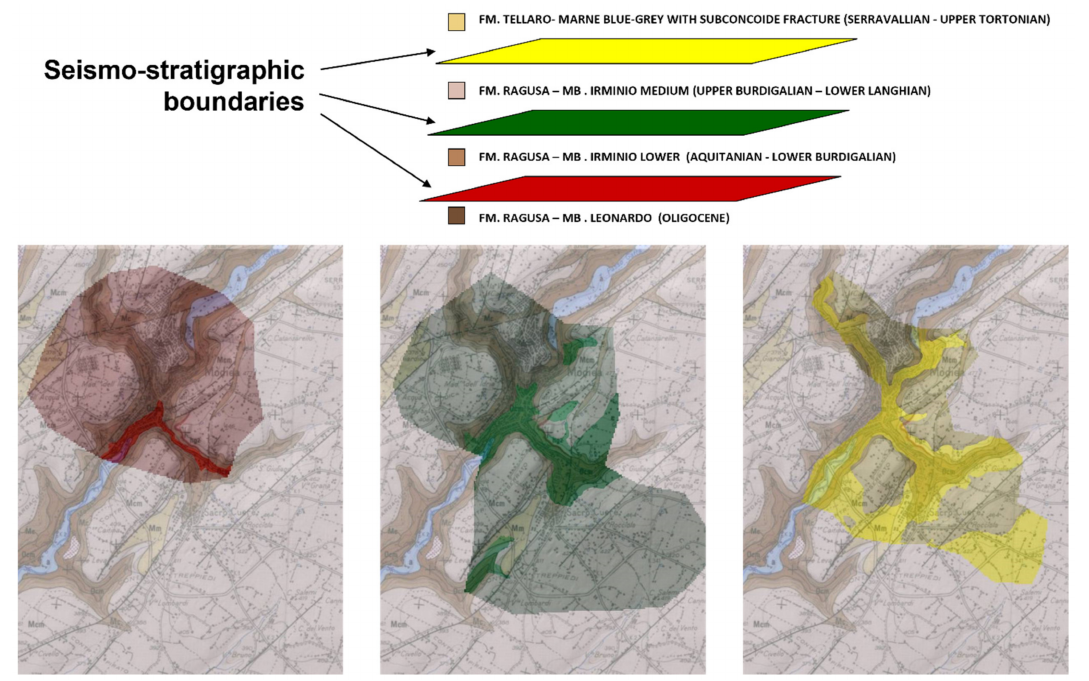
Figure 8. The three seismo-stratigraphic boundaries projected in transparency on the geological map of Modica territory. The less transparent areas are those with an altitude greater than the topography.